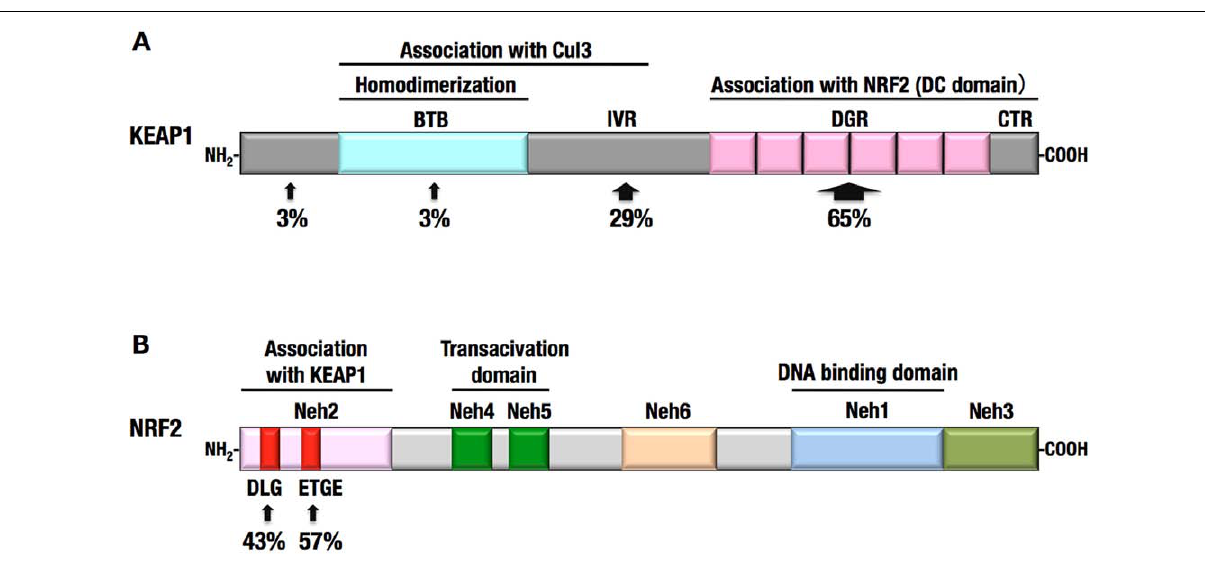
the increased expression of cytoprotective genes. Importantly, the abnormal accumulation of p62 is often observed in certain can- cers,such as hepatocellular carcinoma (Lu et al.,2001; Strnad et al., 2008; Inami et al., 2011), which suggests that the increased activity of NRF2 might contribute to the malignant progression of these